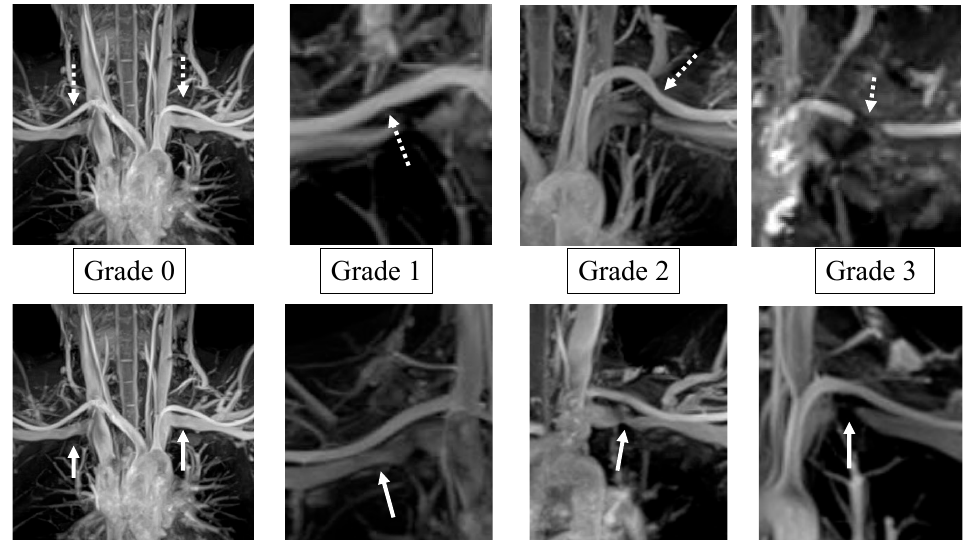
Figure 3. The degree of stenosis of SCA and SCV is classified into 4 levels. Upper row (dotted arrow), a stenosis part of SCA. Lower row (solid line arrow), a stenosis part of SCV. Grade 0; no stenosis. Grade 1; mild stenosis, less than 50%. Grade 2; moderate stenosis, more than 50%. Grade 3; severe stenosis to the point of discontinuity. SCA, subclavian artery; SCV, subclavian vein.